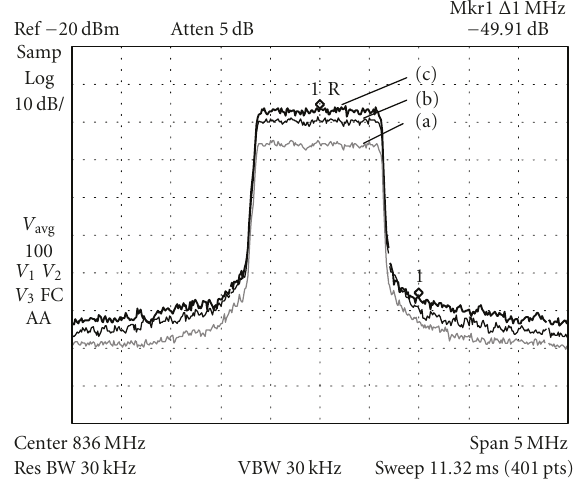
Figure 4: Power spectral density measurements at the output of the 1W handset PA when (a) the input was backed-o ff , (b) a memo- ryless polynomial PD ( Q = 0, K = 5) was applied, and (c) both SLMTC ( M = 16, γ 0 = 7 . 5dB) and the memoryless polynomial PD ( Q = 0, K = 5) were applied.